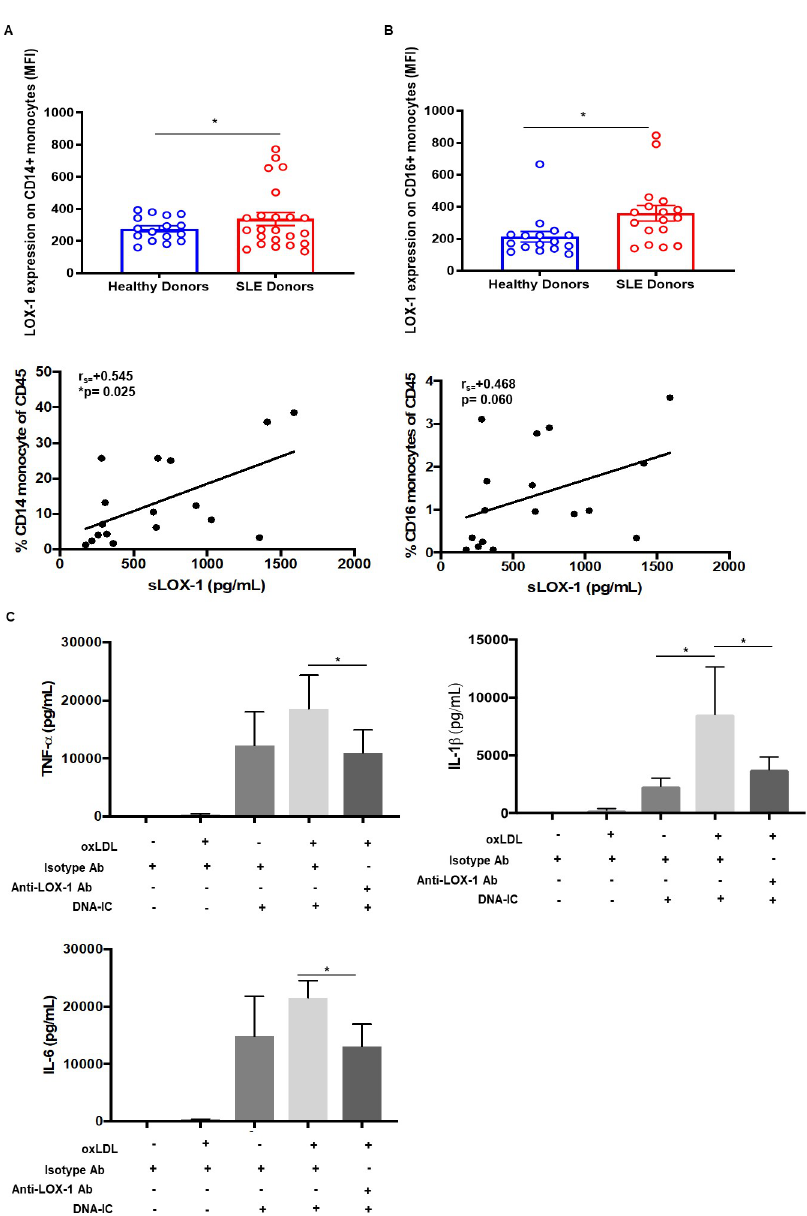
Fig 4. Flow cytometric assessment of LOX-1 on SLE monocytes and oxLDL-induced proinflammatory cytokine secretion from healthy monocytes. Flow cytometric analysis was performed on PBMCs from SLE patients (n = 17) and healthy individuals (n = 15) for LOX-1 expression. After gating out T cells, B cells and granulocytes, (A) and (B) CD14+/CD16+ staining was used to determine LOX-1 expression on monocytes (top panel). Spearman correlation (r s ) between numbers of CD14+ and CD16+ monocytes and sLOX-1 (bottom panel). (C) Cytokine secretion measured using MSD-based immunoassay depicts TNF- α , IL-1 β and IL-6 levels upon oxLDL (30 μ g/mL) priming for 3h, followed by DNA-IC (20 μ g/mL) stimulation by itself and in combination for 24h. n = 4. Data represented as mean ± SEM. � p < 0.05, �� p < 0.01, ��� p < 0.001 and ���� p < 0.0001. LOX-1 upon oxLDL, DNA-IC and ox-LDL + DNA-IC stimulation at 24h (Fig 5A and 5B). A strong correlation was found between membrane and soluble LOX-1 levels (r p = 0.008), indicating that the source of sLOX-1 may be membrane LOX-1 (Fig 5C). Previ- ously, LOX-1 has been shown to be cleaved by ADAM activity [30, 31]. To determine if this is